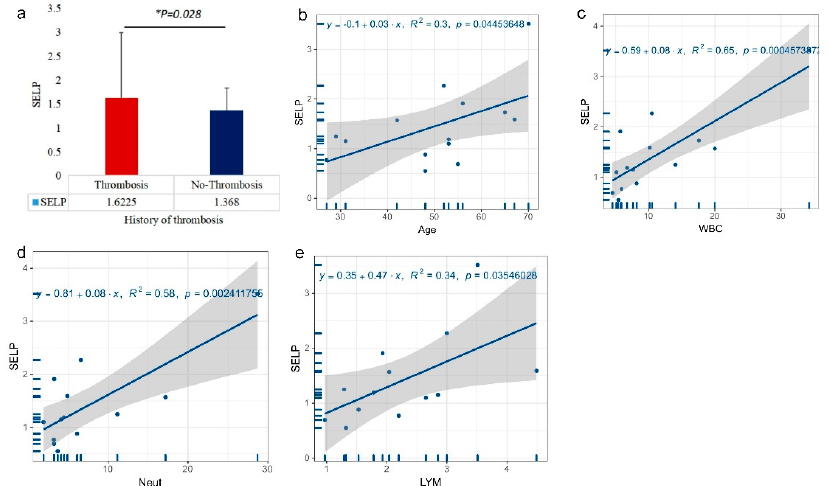
between patients with and without a history of thrombosis, ( b ) regression of age and SELP levels,